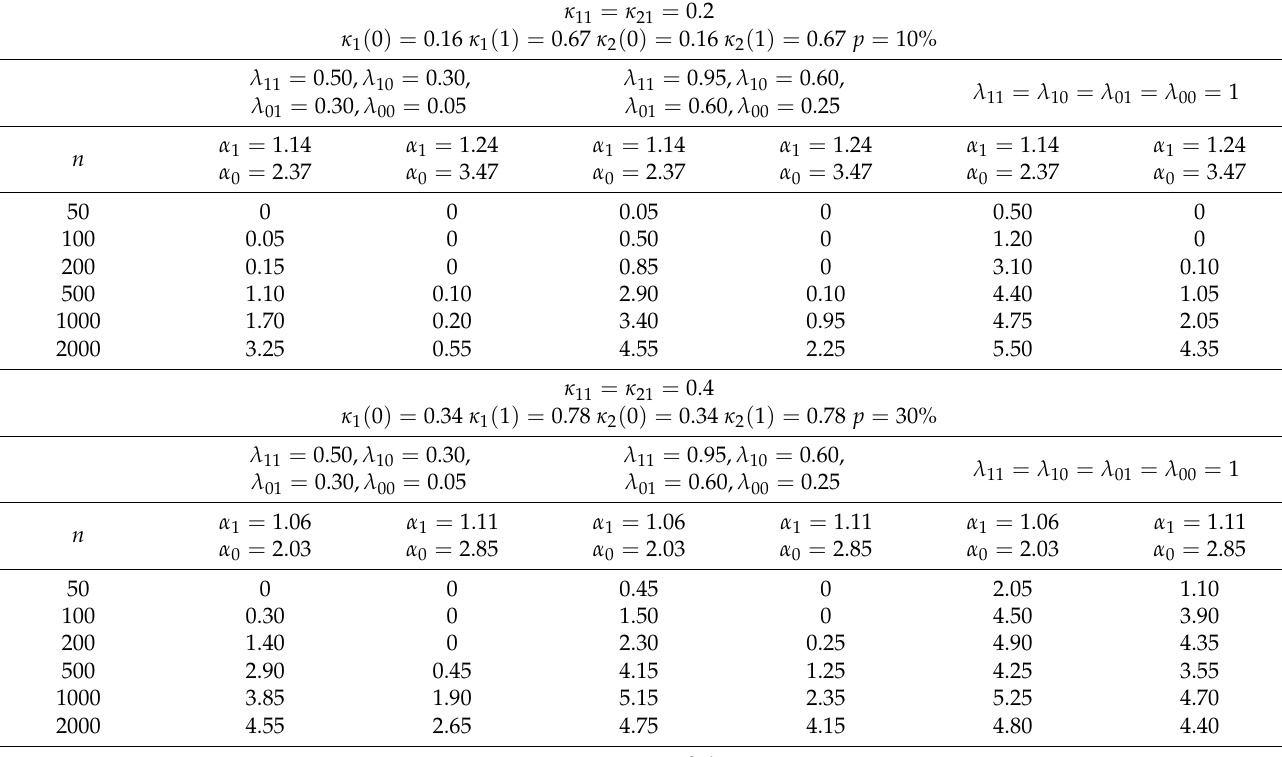
Table 3. Type I error (in %) of the hypothesis test when L (cid:48) > L (0 ≤ c < 0.5). κ 11 = κ 21 =